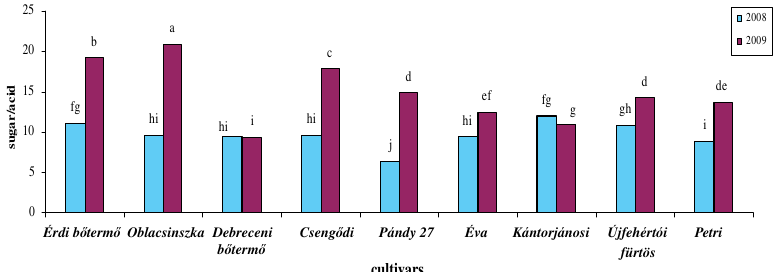
Figure 11. Sugar/acid ratios of the studied sour cherry cultivars in tow years (2008 & 2009). Different letters indicate significant differences between treatments (P